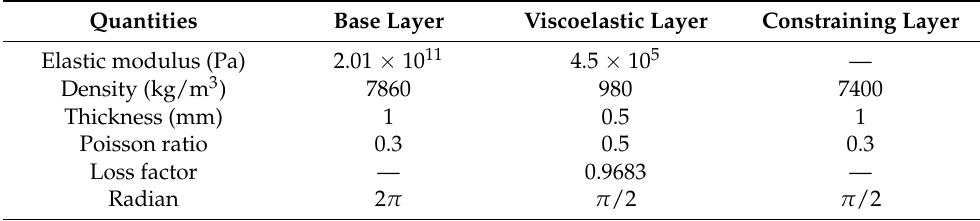
Figure 3. View of adjacent elements. Table 1. Geometrical and material of ACLD pipeline.